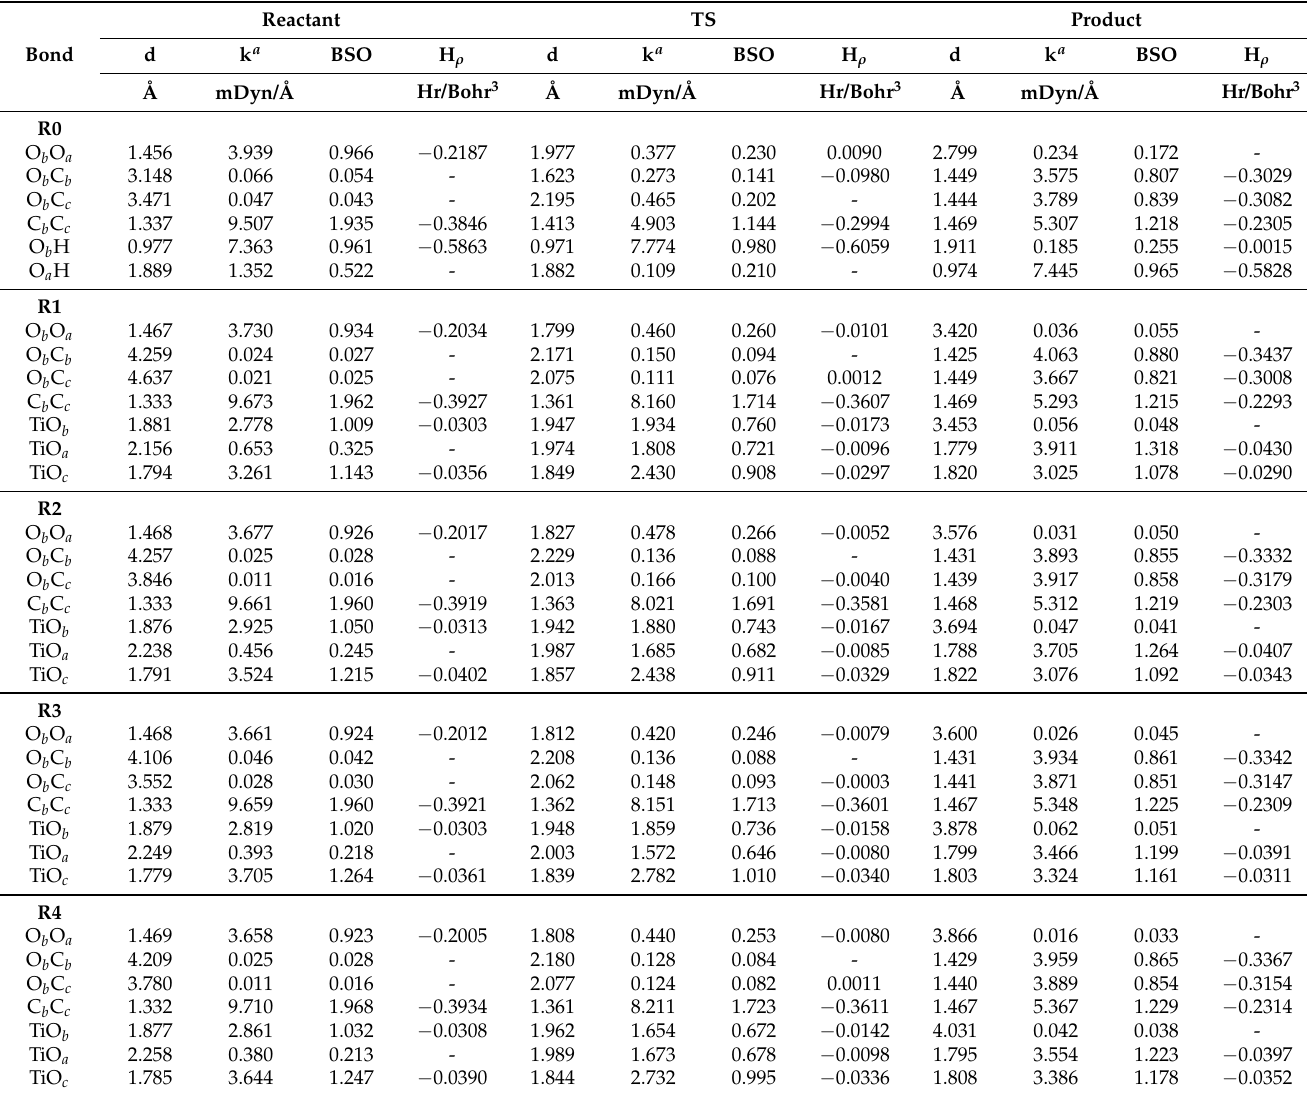
Table 4. Bond length d, local mode force constant k a and corresponding bond strength order BSO and energy density at the bond critical point H ρ , for selected bonds of the reactant van der Waals complex, TS and product of the van der Waals complex for reactions R0 – R4 , investigated in this study. For atom labels, see the text and Figure 2. B3LYP/6-31G(d,p)/SDD(Ti) level of theory. TS